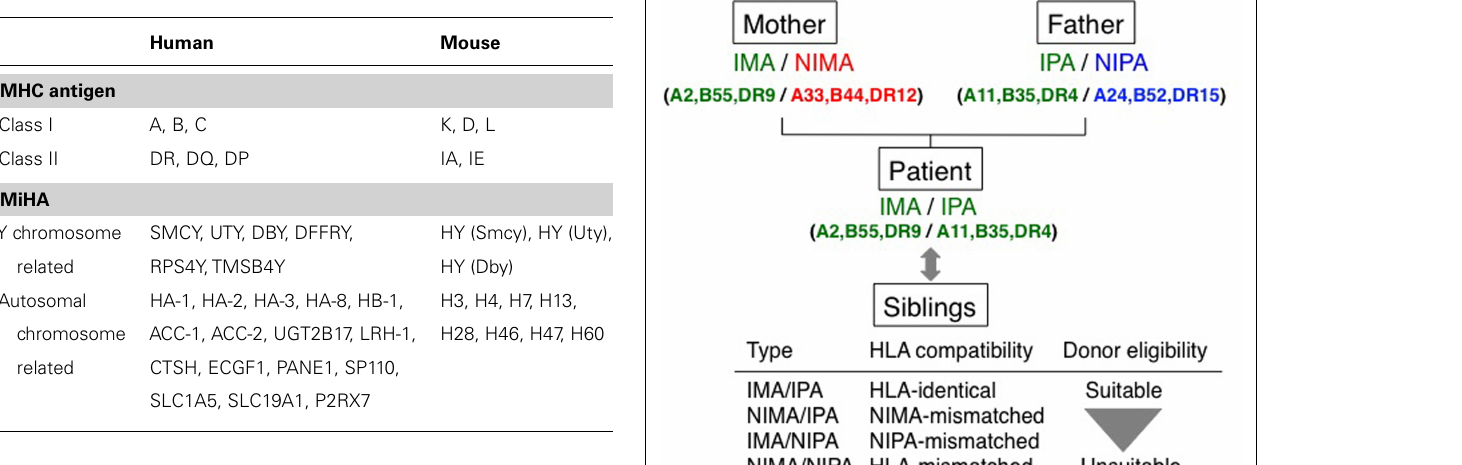
Table 1 | Histocompatibility antigens in humans and mice.